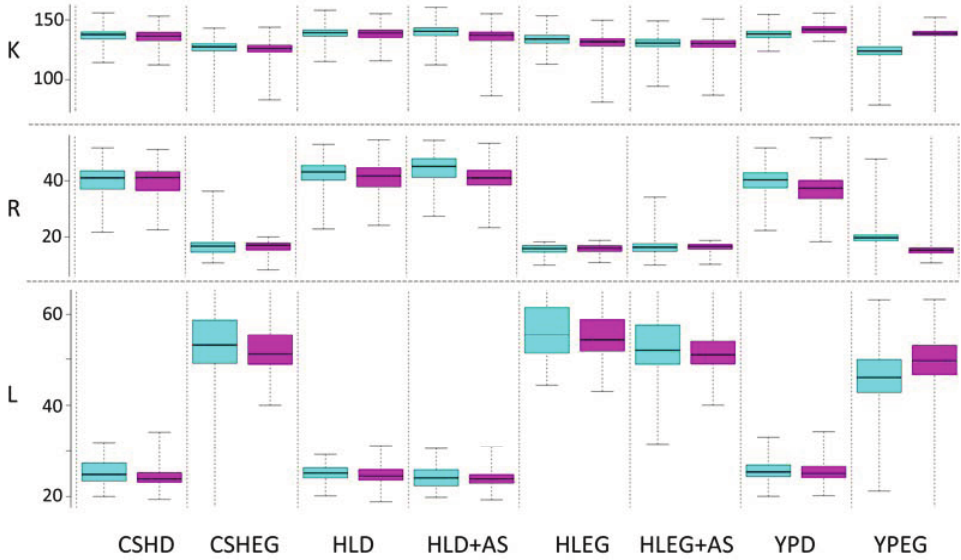
Figure 2. Cell proliferation phenotypes (CPPs) for BY4741 are similar in HL and standard yeast media. Box plots represent the central 75% (colored box), median (bold bar), and range (whiskers). Media types include Cold Spring Harbor (CSH), human-like (HL) with or without 0.5 gm/L ammonium sulfate (AS), or rich yeast/peptone (YP). Each media type was prepared with either dextrose (D) or ethanol glycerol (EG) as a carbon source.